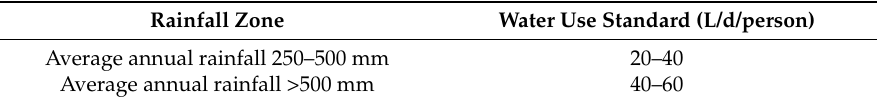
Table 2. Standard for a rainwater harvesting utilization system for household domestic water use.